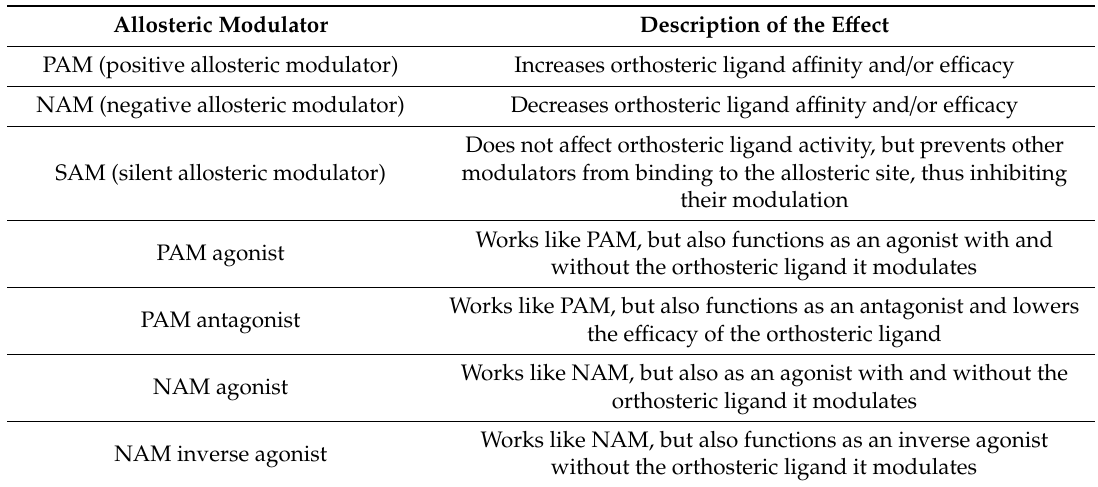
Table 1. Classification of the various allosteric modulators and description of their e ff